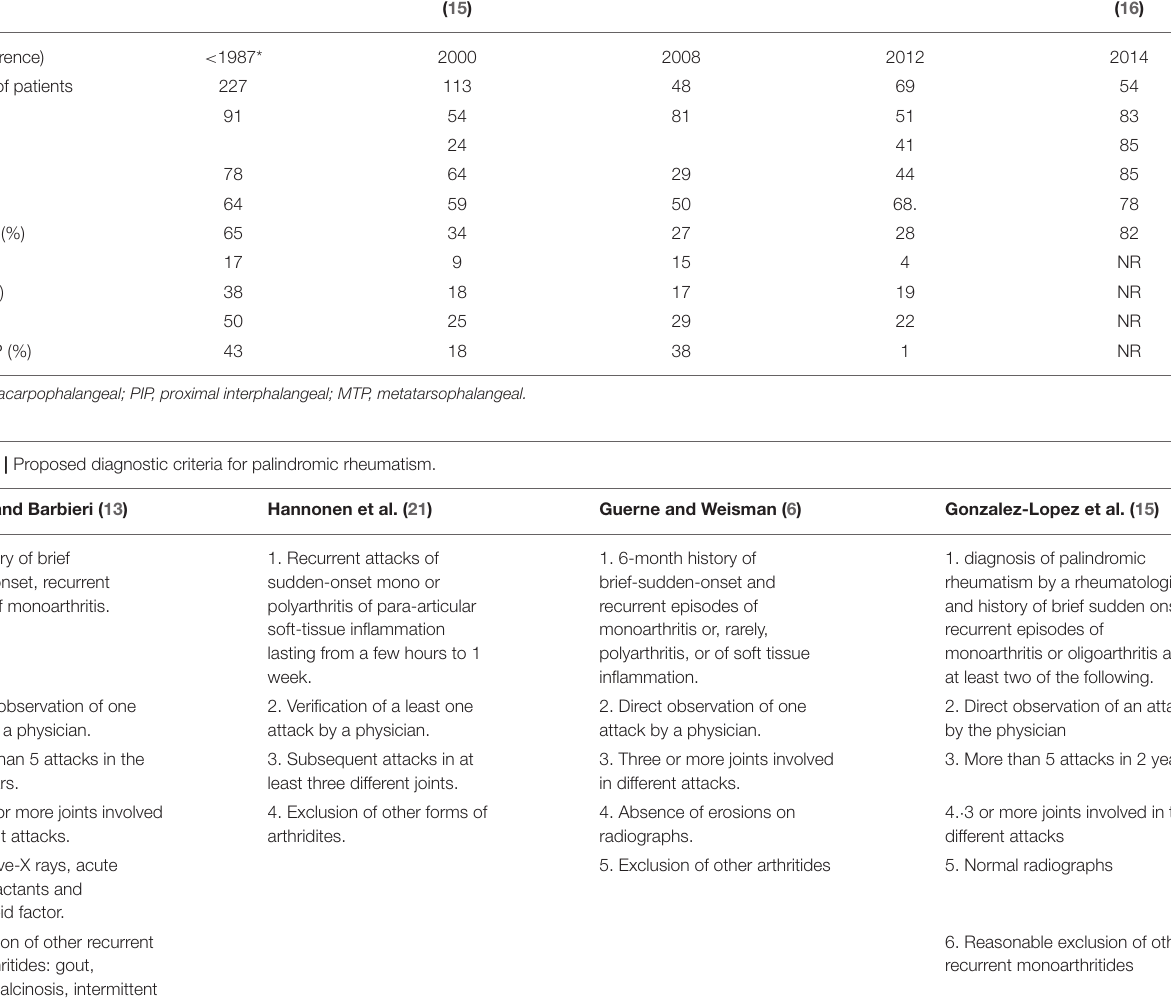
TABLE 2 | Distribution of the joints involved in PR in different series.